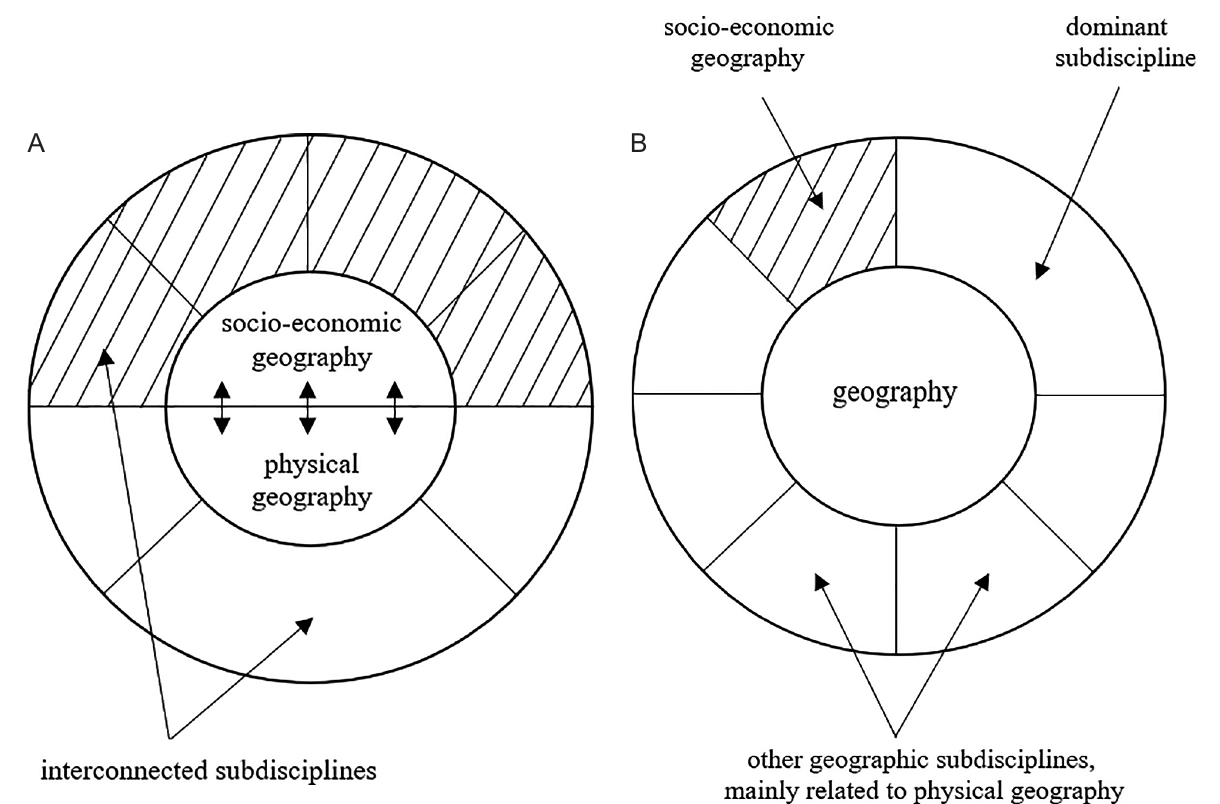
Fig. 1. Position of socio-economic geography in two separate structural models of geography as a science. (A) Model of balanced proportions between physical geography (with its subdisciplines) and socio- economic geography (with its subdisciplines). (B) Model in which socio-economic geography is one of many geographical subdisciplines. Source: own